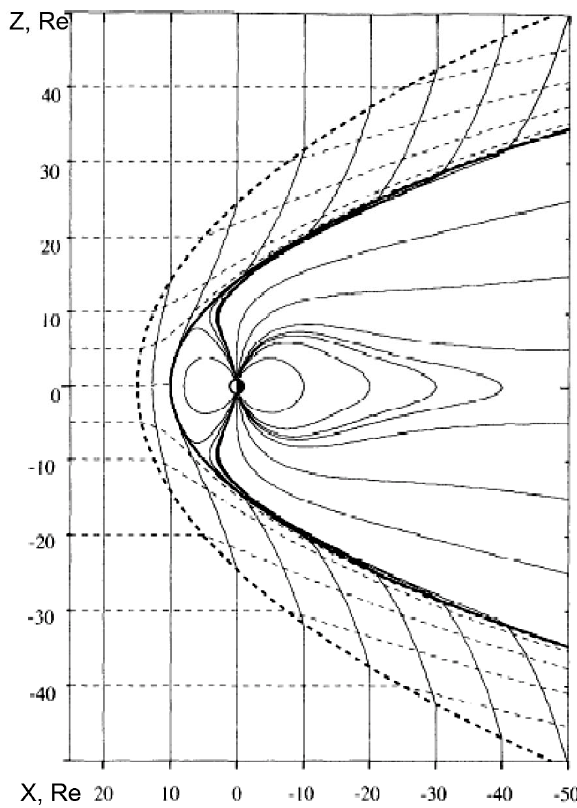
Fig. 4. The interplanetary and magnetospheric magnetic field lines in the noon-midnight plane are shown (thin solid curves), as well as the magnetopause (thick solid curve). Upstream of the bow shock and in the magnetosheath we also see the streamlines of the solar wind flowing past the magnetosphere (thin dashed curves).